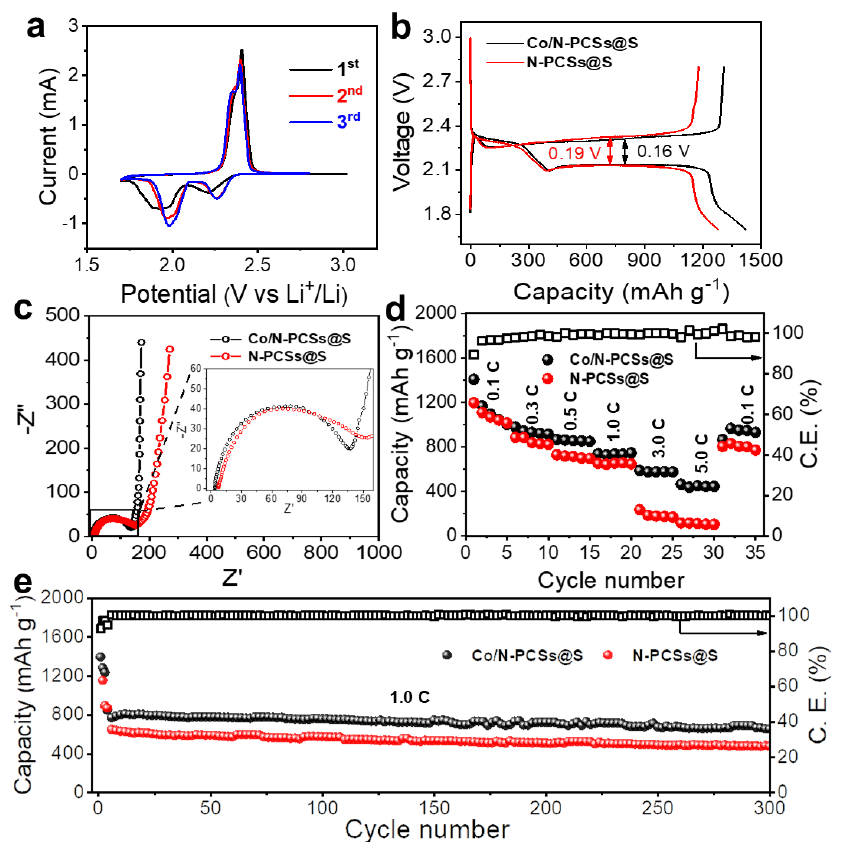
Figure 4. ( a ) CV profile at a scan rate of 0.1 mV·s -1 for Co/NPCSs@S, ( b ) galvanostatic charge/discharge profiles for initial three cycles at 0.1 C, ( c ) Nyquist impedance plots, ( d ) rate performance and ( e ) cycling performance at 1 C of N-PCSs@S and Co/N-PCSs@S.